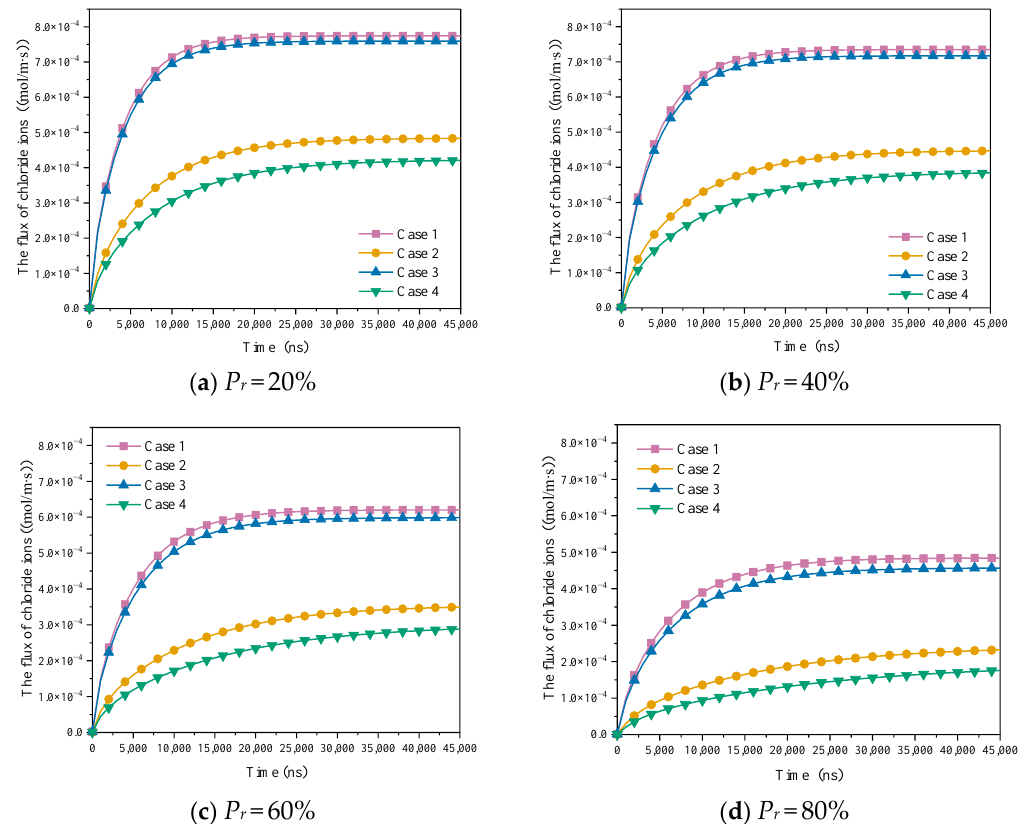
Figure 12. The influence of slippage to molar flux of chloride ions at micron scale.